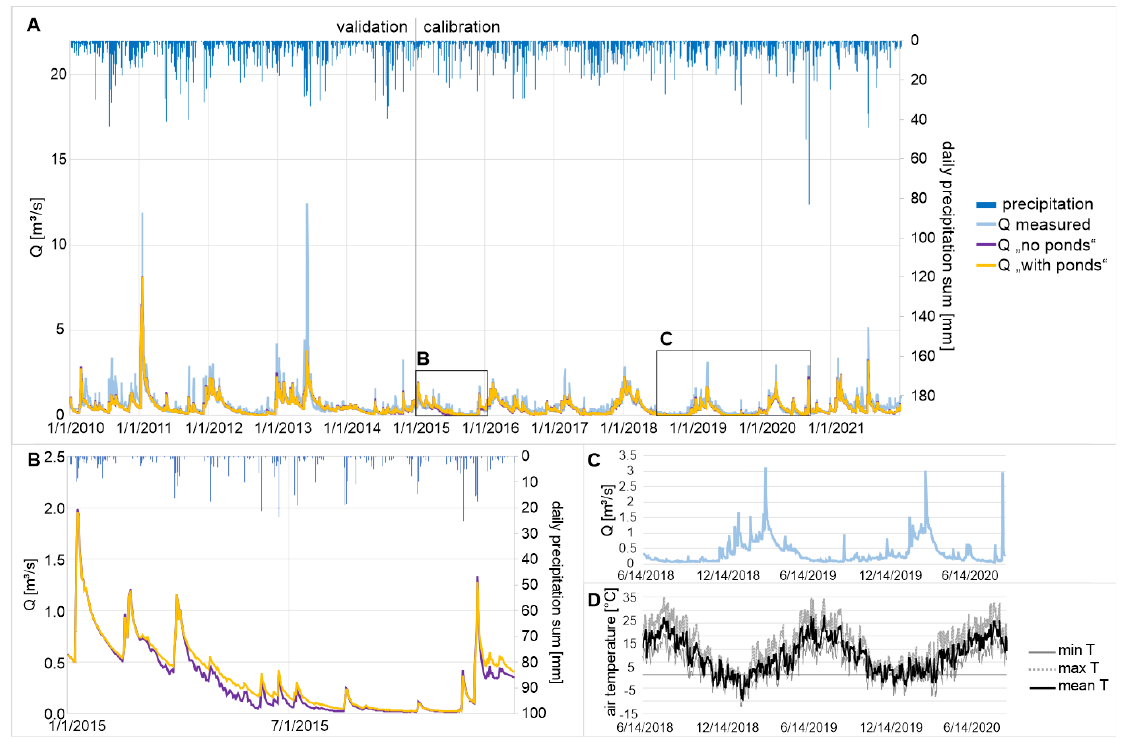
Figure 2. Discharge, precipitation and air temperature of the study area: ( A ) observed stream flow (Q measured, light blue line), modeled stream flow Q for scenarios with (yellow line) and without ponds (violet line) and precipitation (blue bars) at the climate station “Rehau” for the whole time period not including warm-up; dark line separated the calibration from the validation period. ( B ) close-up into the simulated streamflow with and without ponds in 2015; ( C ) close-up into the measured streamflow for the period of the temperature study; ( D ) mean (black line), minimum (solid grey line) and maximum (dotted grey line) air temperature at the climate station “Hof” for the period of the temperature study.